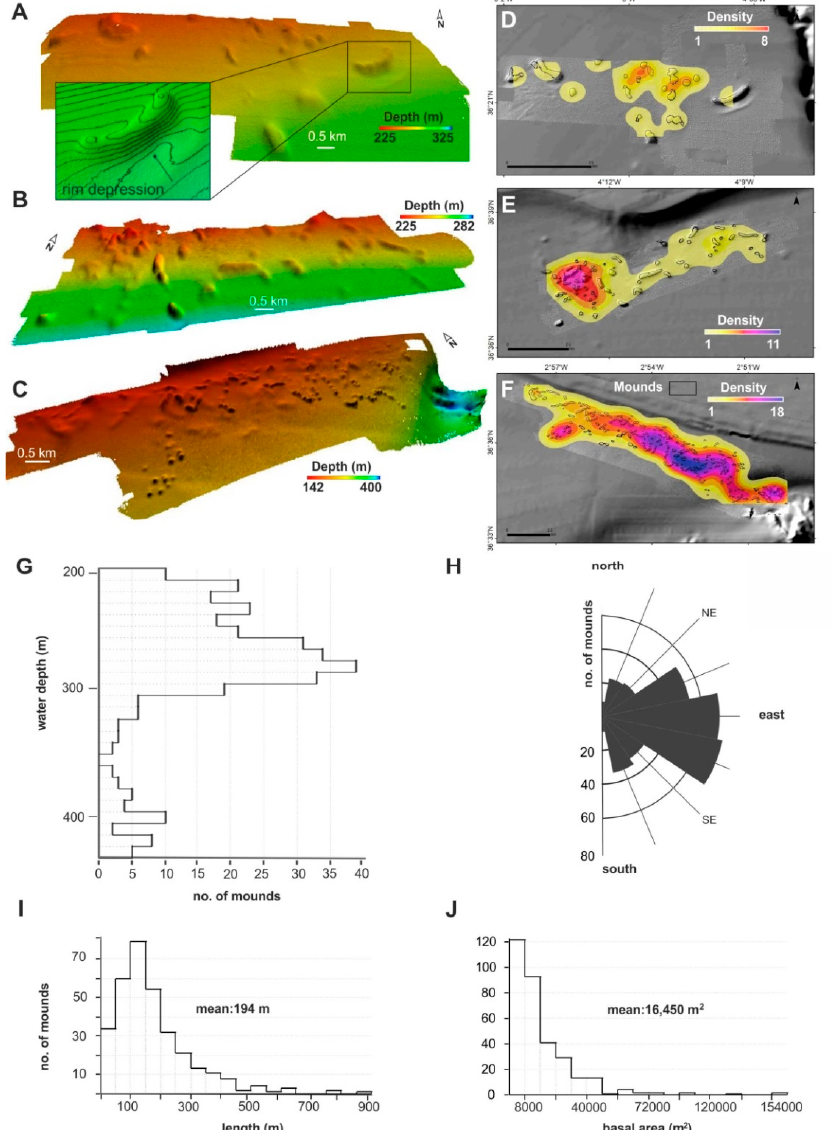
Figure 2. Spatial distribution and main morphological variables of the 325 carbonate mounds detected in the three mound fields of the northern Alboran Sea. ( A – C ) 3D bathymetric images of the carbonate mound fields with a vertical exaggeration of 6. ( A ) Alcántara mound field; ( B ) Málaga mound field and ( C ) Aceitunas mound field. ( D – F ) Kernel density maps (mound per km 2 ) of the mound fields based on mound contours. The black scales represent 2.5 km. ( G – J ) Morphometric data of the analyzed geomorphological features: ( G ) Bathymetric distribution of carbonate mounds in terms of the number of mounds; ( H ) Main trends of length axes orientation of the carbonate mounds. Histograms show ( I ) the length and ( J ) the basal area covered by the mounds.